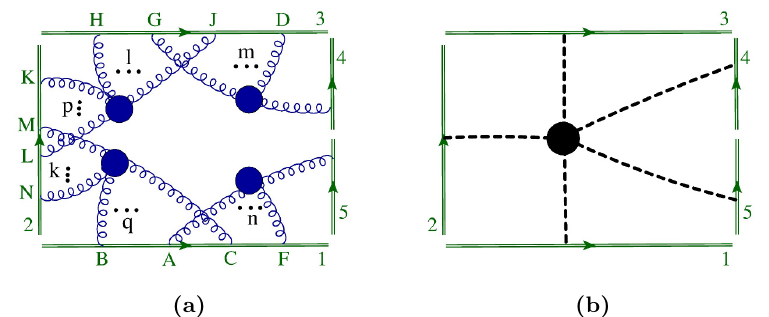
(1 , 1 , k + p, m + l, q + n ) 5